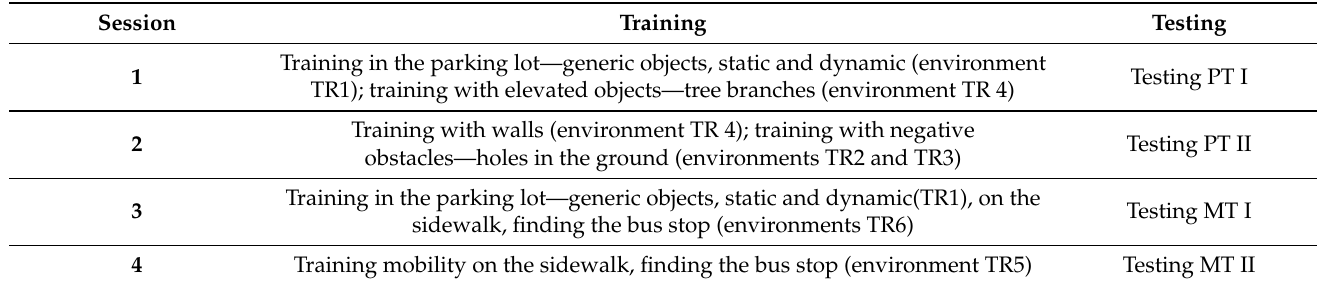
Table 1. Overview of the training and testing sessions in outdoor environments (TR—training session, PT—perception testing session, MT—mobility testing